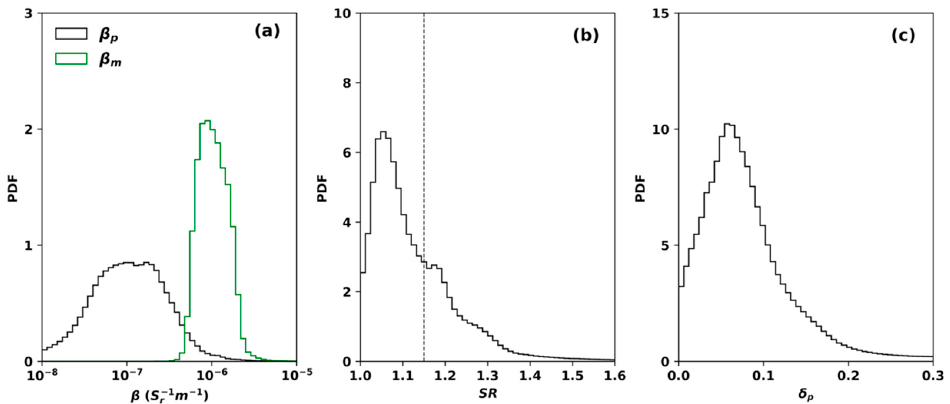
Figure 6. Probability Distribution Function (PDF) of: ( a ) β p and β m ; ( b ) aerosol SR , the dashed line at the SR value of 1.15 is the threshold above which δ p are analyzed; ( c ) δ p between the surface and 8 km.